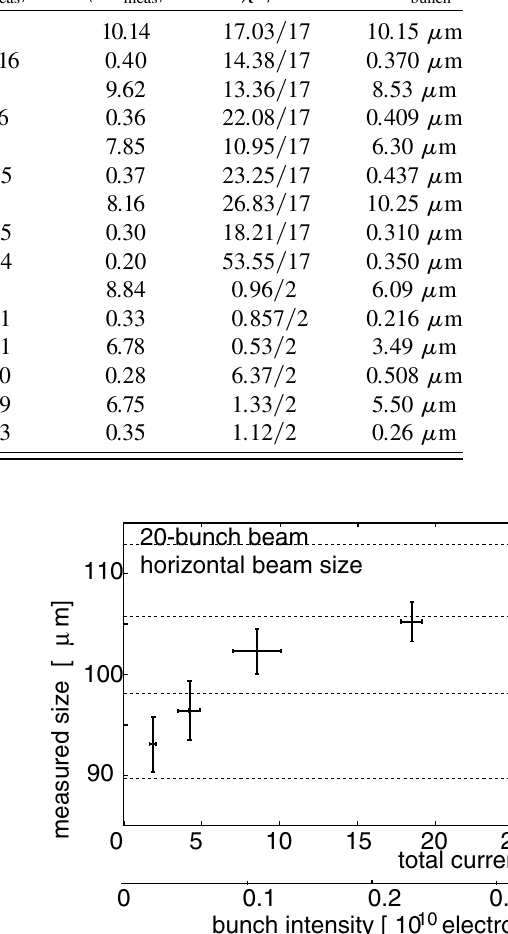
2 We expect the main source to be the beam orbit drift during the measurement. Other possible sources are bunch-to-bunch dependence of the beam central position and/or energy. How- ever, there was no evidence in the data large enough to prove such